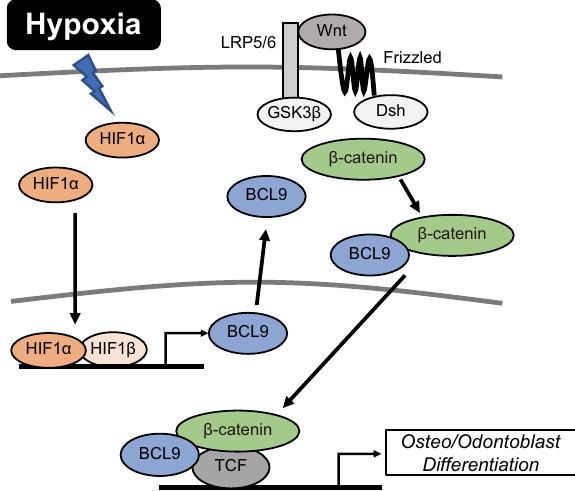
Figure 7. A schematic diagram showing the action of HIF1α on osteo/odontoblast differentiation via Wnt/β- catenin signaling in hDPSCs. Hypoxia induces the stabilization of HIF1α and HIF1α stimulates the expression of BCL9, which in turn activates Wnt/β-catenin signaling and induces the osteo/odontoblast differentiation of